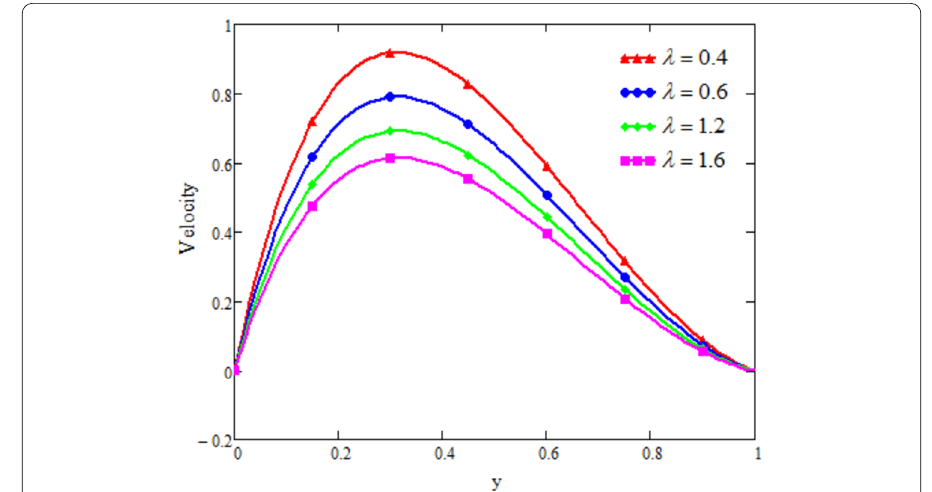
Figure 10 Velocity curves along λ variation and α = 0.5, P r = 11.5, G r = 6.5 K = 2, λ 1 = 1.8, H a = 0.6, t = 5